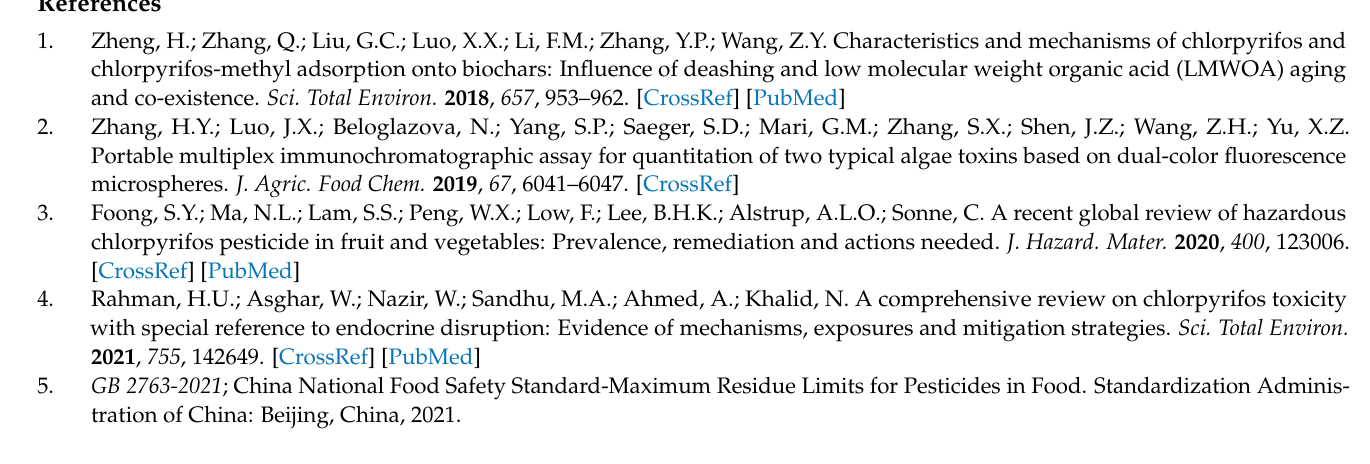
-H 1 ; Figure S2: 1 H NMR spectrum of CPS-H 1 ; Figure S3. ESI-MS spectrum (negative) of CPS-H 2 ; Figure S4. 1 H NMR spectrum of CPS-H 2 ; Figure S5. The UV wavelength scanning spectra of artificial antigens. (a) CPS-H 1 -BSA. (b) CPS-H 2 -LF. (c) CPS-H 2 -BSA; Figure S6. The electron microscope scan of fluorescence microspheres; Figure S7. The signal intensity and inhibition results of (a) The labeling pH value; (b) The concentrations of antigen and antibody; (c,d) The pH and ion concentration of the CPSE standard buffer. The spiked target concentrations of the inhibitory effect in Figure S7 (a–d) were 1 µ g/mL; Figure S8. The signal intensity and inhibition results of fluorescence probe dilution (a) pH; (b) BSA concentration; (c) Sucrose concentration; (d) Tween-20 concentration. The spiked target concentrations of the inhibitory effect were 1 µ g/mL; Figure S9. The signal intensity and inhibition results of sample pad pretreatment solution (a) Sucrose concentration; (b) Tween-20 concentration; (c) BSA concentration; (d) pH. The spiked target concentrations of the inhibitory effect were 1 µ g/mL; Figure S10. Optimization of sample pretreatment conditions (n = 3). (a) Extraction solution. (b) Extraction temperature; Table S1. Characterization of the mouse antiserum against free CPSE; Table S2. Stability of fluorescent liquid (n = 3); Table S3. Stability of FICA (n = 3); Table S4. Test results of precision of intra-assay (n = 3); Table S5. Test results of precision of inter-assay (n =